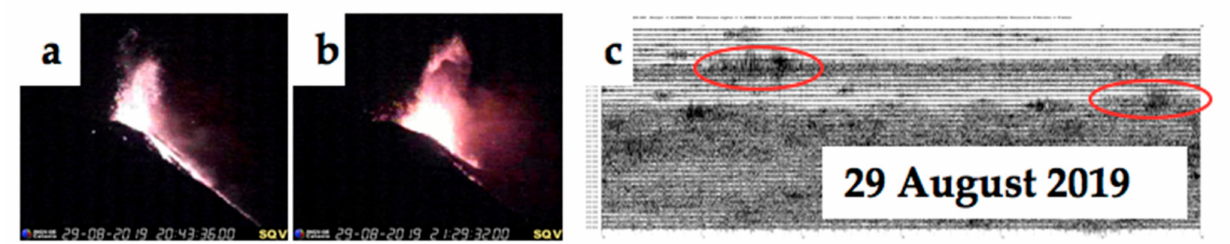
Figure 8. ( a , b ) Visual images from the SQV camera of the 29 August 2019 events recorded at 20:43:36 ( a ) and at 21:29:32 ( b ), view from NE. ( c ) Seismicity of 29 August 2019 as recorded from the IST3 seismic station, Z component. The two red ovals indicate the seismic trace corresponding to the two events shown above. See Figure 1 for station locations.